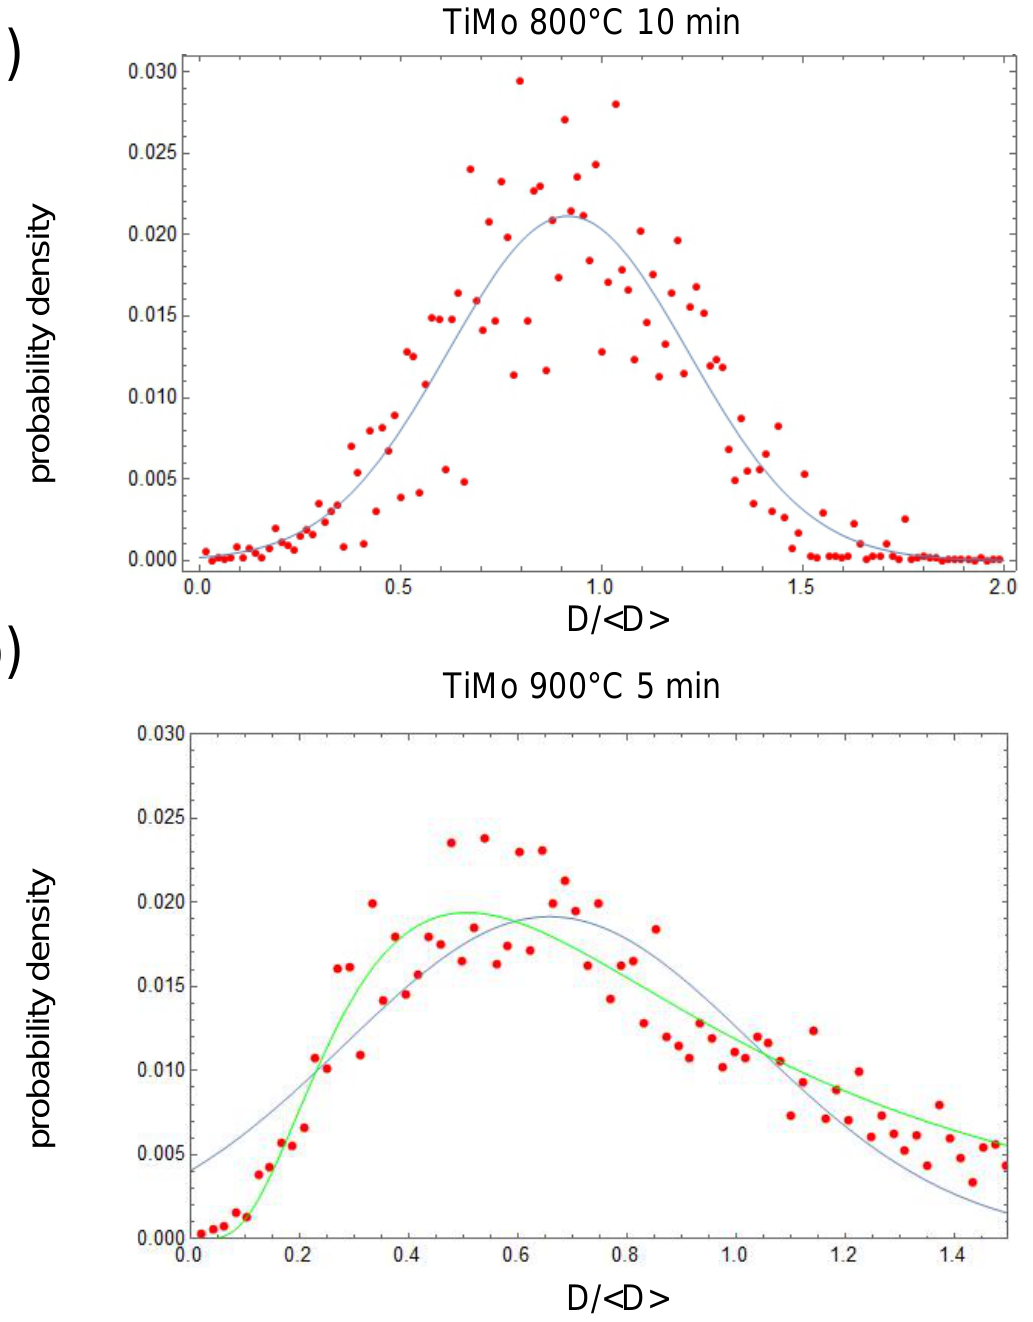
Figure 5. Ligament diameter distribution histograms of the open porous TiMo samples dealloyed at 800 ◦ C for 10 min ( a ) and at 900 ◦ C for 5 min ( b ). Note: Gaussian fit (blue) and log normal fit (green) of the scaled ligament width histograms scaled by the mean ligament width < D >